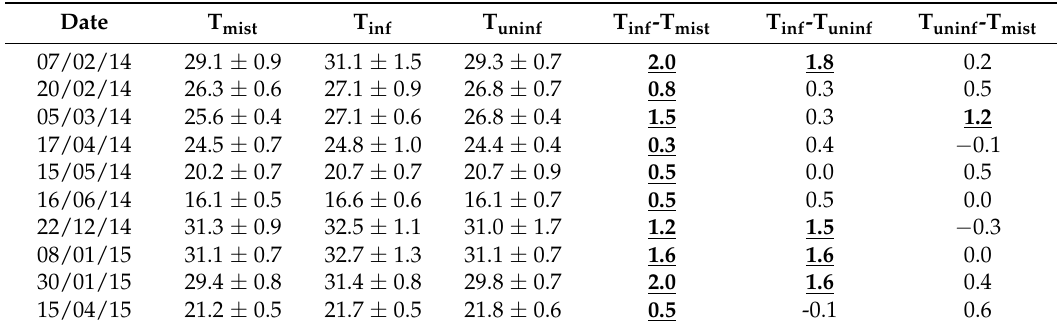
Table 2. Overview of canopy temperatures of mistletoe (T mist ), infected eucalypt (T inf ) and uninfected eucalypt (T uninf ) canopy (all in °C).